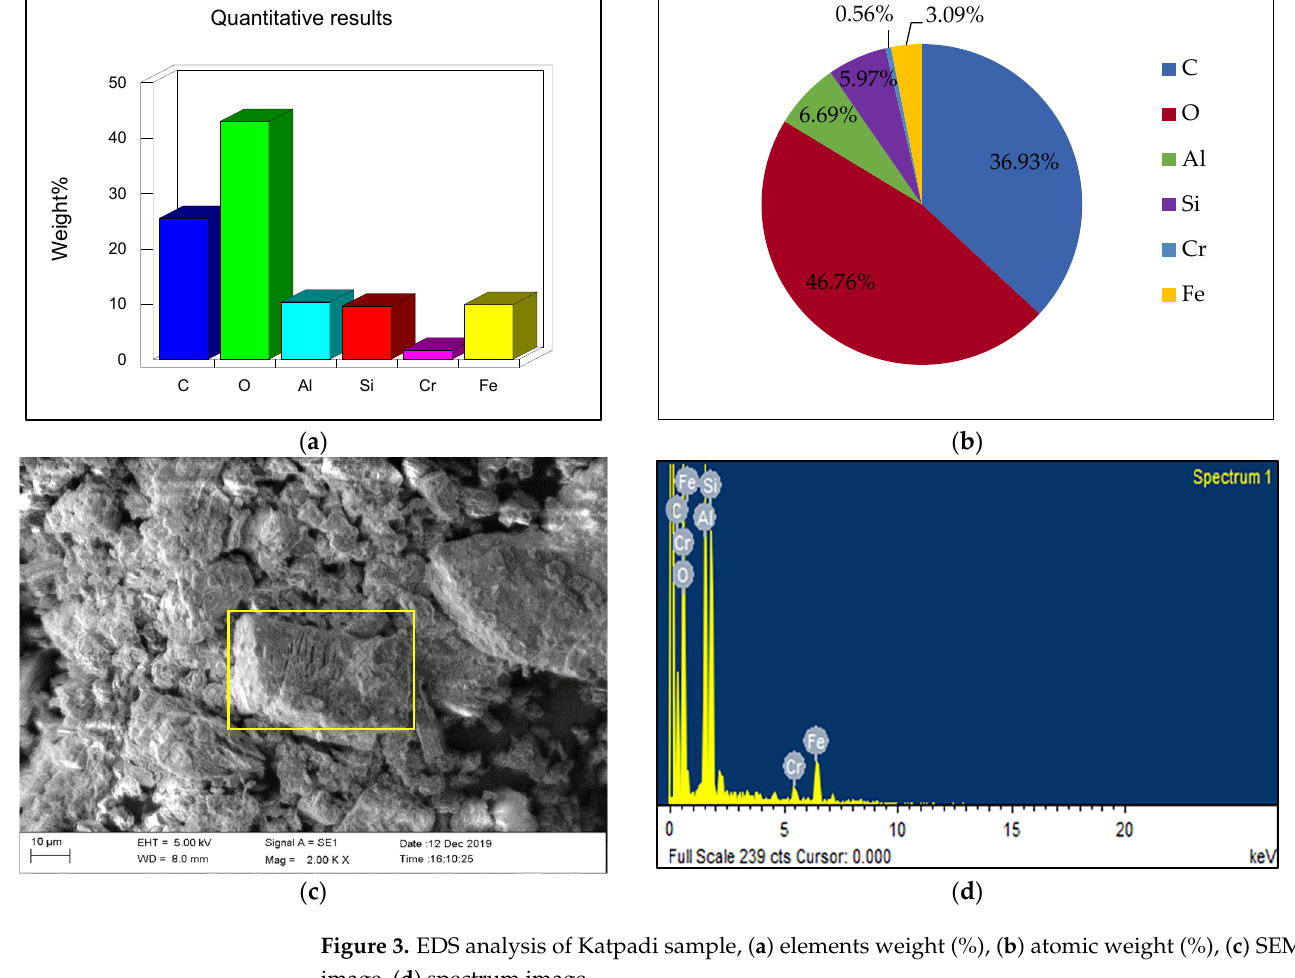
Figure 3. EDS analysis of Katpadi sample, ( a ) elements weight (%), ( b ) atomic weight (%), ( c ) SEM image, ( d ) spectrum image.